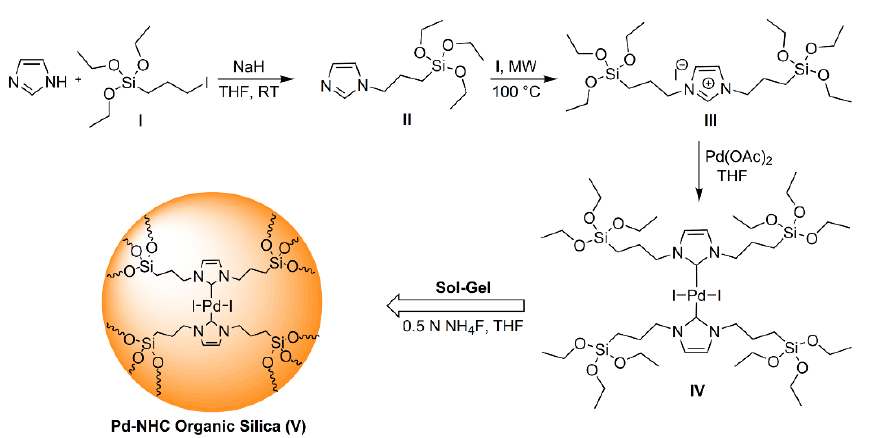
Figure 20. Preparation of Pd-NHC organosilica [112]. Reprinted with permission from [112]. Copy- right 2008, Elsevier.